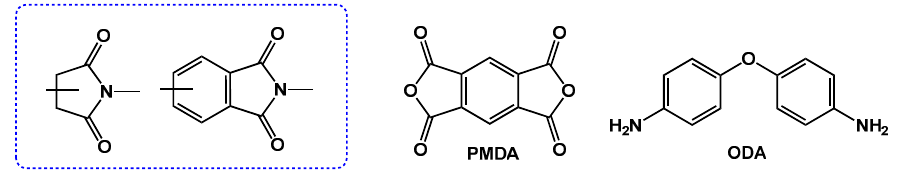
Figure 1. The characteristic imide rings in the PI backbone and the structure of PMDA and ODA. However, the color of aromatic PI films is typically yellow or brown, with poor light transmittance. For instance, Kapton™, with a thickness of 80 µ m, exhibits a brown color, and its cut-off wavelength (initial wavelength corresponding to light transmittance exceeding 1%, λ 0 ) locates as long as 455 nm. A 50 µ m Kapton™ obtains light transmittance (T%) of merely 80.9% at 760 nm [54]. The deep color of PI films results from the formation of intra- and intermolecular charge transfer complexes (CTCs, as plotted in Figure 2) between aromatic dianhydrides (electron acceptors) and diamines (electron donors), causing strong filtration in the visible region. The generation of CTCs depends on the energy gap between the highest occupied molecular orbital (HOMO) of diamine and the lowest unoccupied molecular orbital (LUMO) of dianhydride monomers [55,56]. The larger energy gap leads to the light absorption of a shorter wavelength, a lighter color of PIs. Moreover, electron conjugation in PIs is mainly determined by molecular structure and chain